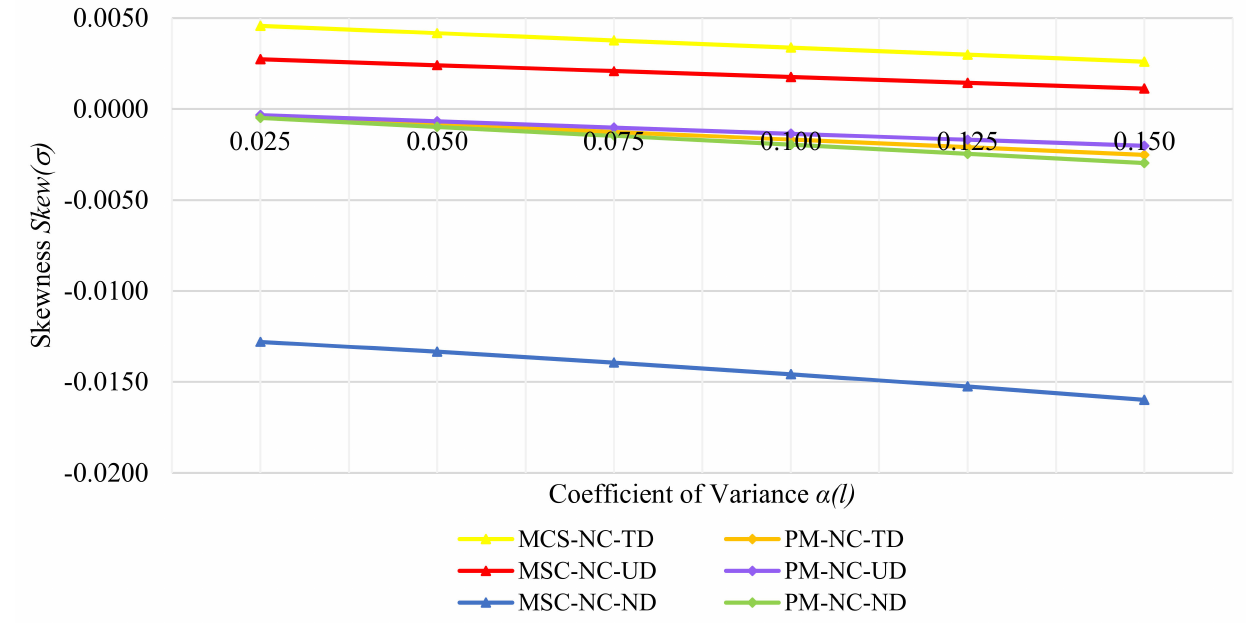
Figure 15. Skewness Skew in the ULS.